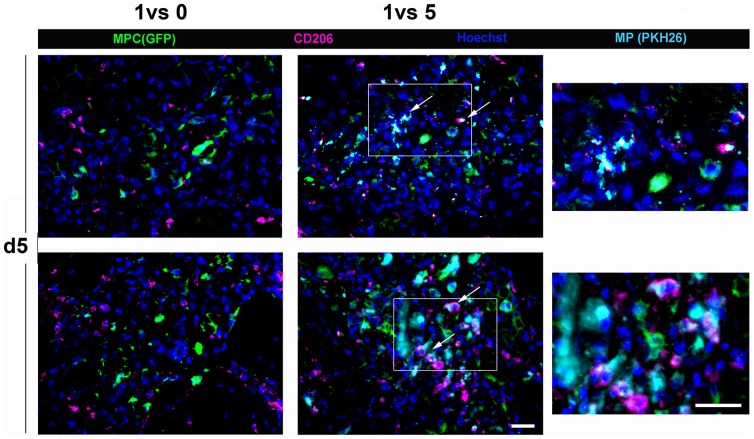
Expression of the M2 marker CD206 by MPs at site of transplantation.GFP-MPCs were injected with or without MPs which were labelled with PKH26 before the cotransplantation into mdx muscle. Immunolabellings of CD206 (magenta) were performed on sections at day 5 after transplantation. Green = MPCs, cyan = PKH-labelled MPS, blue = Hoechst). Arrows show colocalization of cyan and magenta stainings (white) indicating the expression of CD206 by transplanted MPs. Two examples from different muscles are given. Bar = 10 µm. Inserts on the right panel represent higher magnification of the fields delimited by rectangles. Bar = 20 µm.